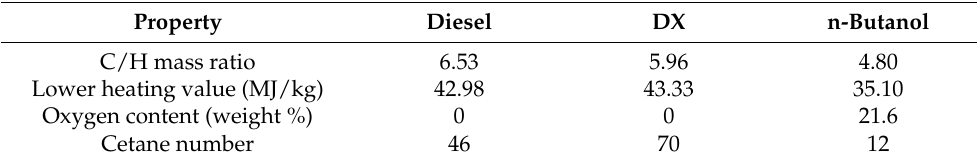
Table 2. Properties of fuels.